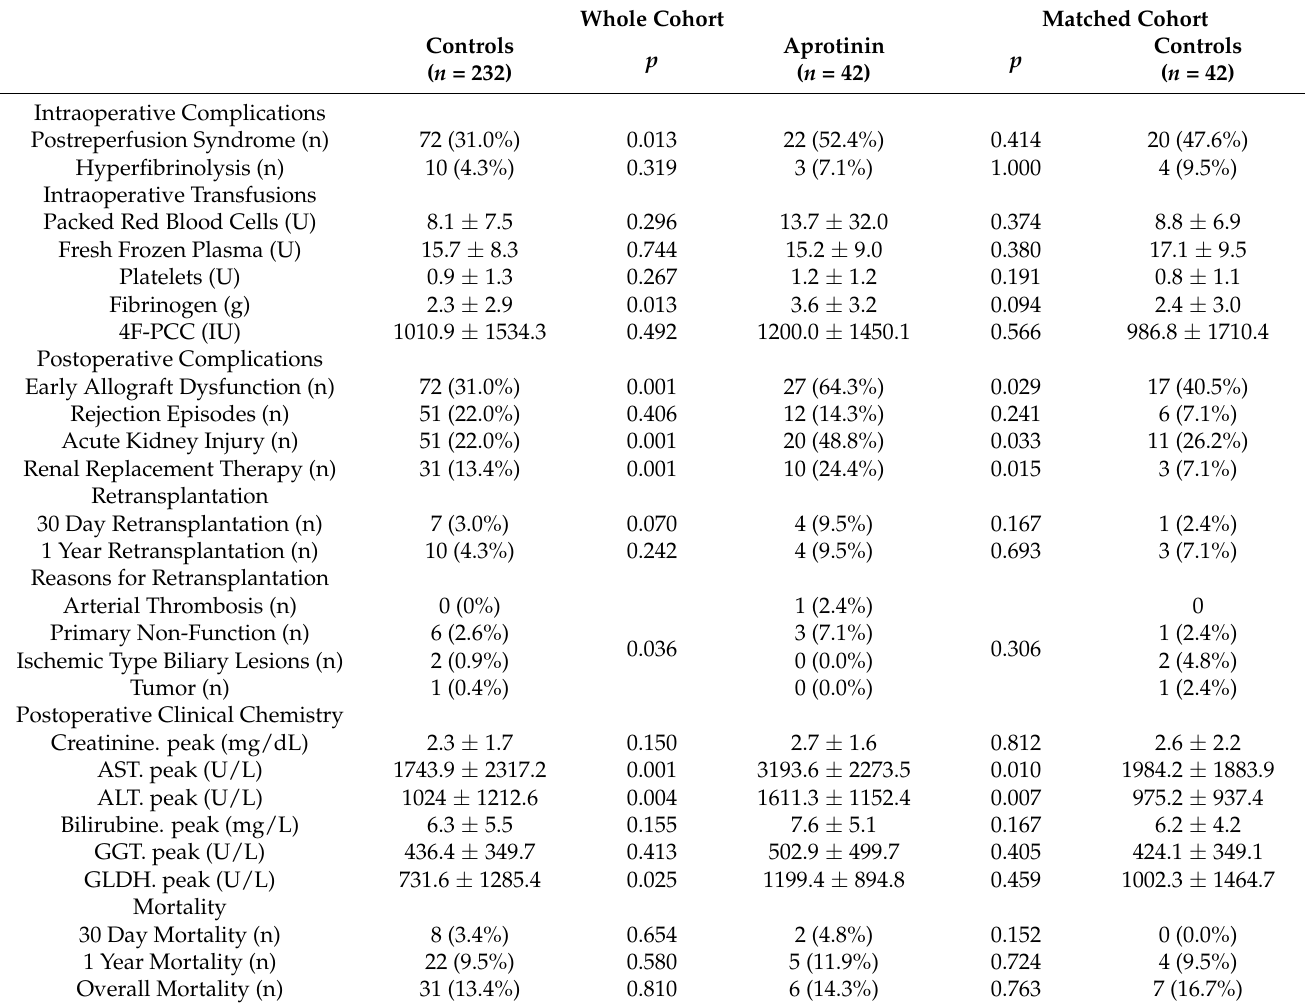
Table 3. Intraoperative and postoperative complications and mortality of 42 liver graft recipients who were intraoperatively treated with aprotinin and 42 propensity score matched controls. The 42 statistically similar recipients who were not treated with aprotinin were identified by propensity score matching in a cohort of 274 single center liver graft recipients. Propensity scores were calculated using organ quality, cold ischemia time and donor